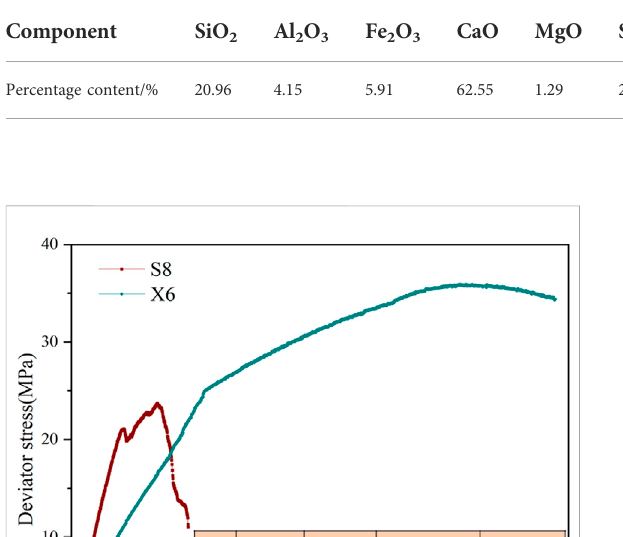
TABLE 9 Chemical composition and mineral composition of sample X6.